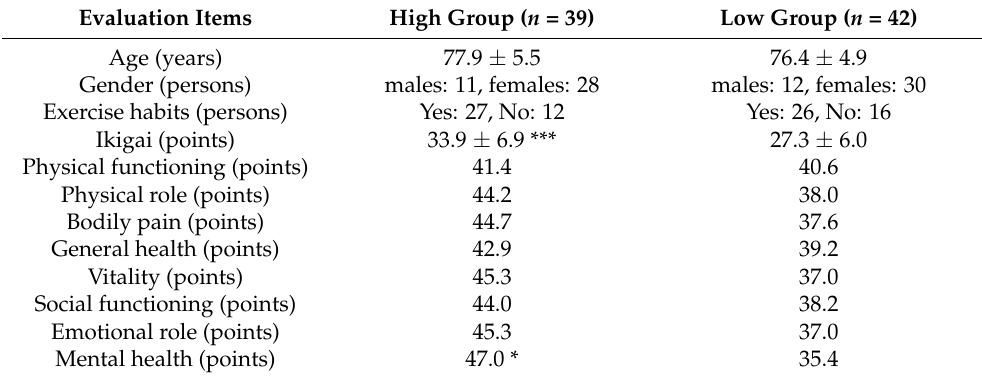
Table 1. Comparison between groups for each value in the high and low life purpose groups.